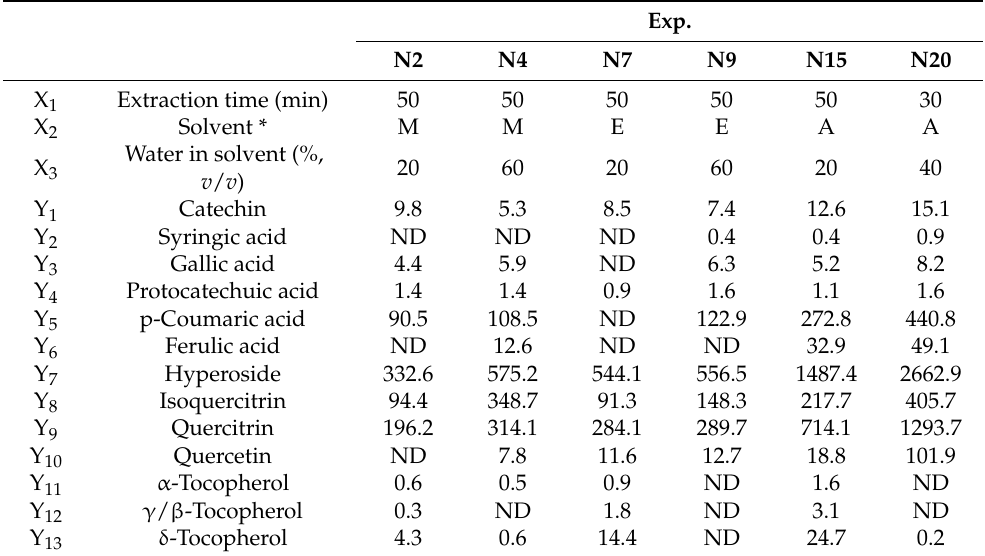
Table 7. Phenolic compounds and tocopherols identified in the walnut flower